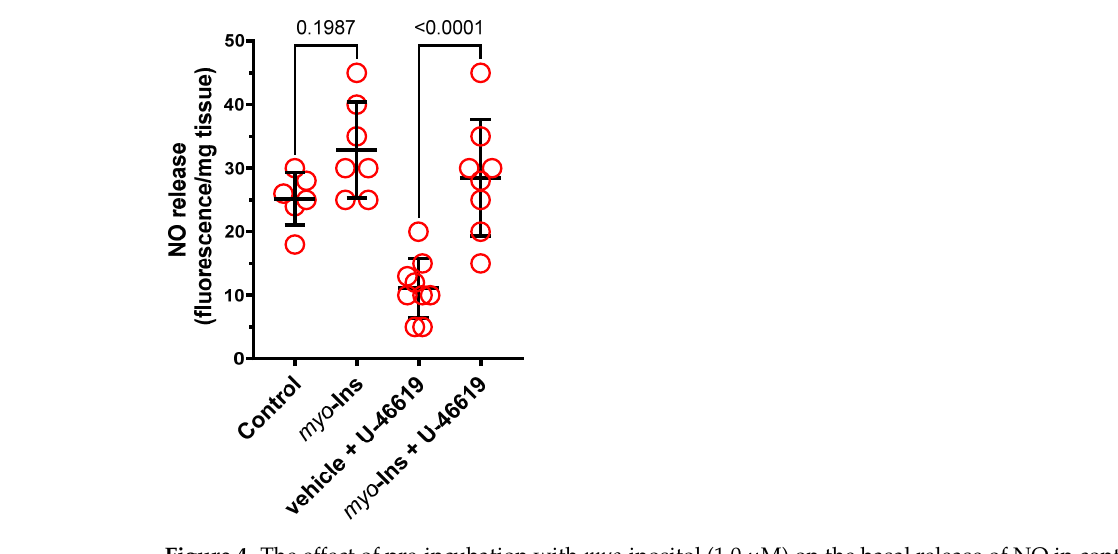
Figure 4. The effect of pre-incubation with myo -inositol (1.0 µ M) on the basal release of NO in control arteries and arteries subjected to U-46619. Results (means ± SD) are expressed as arbitrary units of fluorescence (AU) per milligram of tissue. Number of animals: n = 6–8.